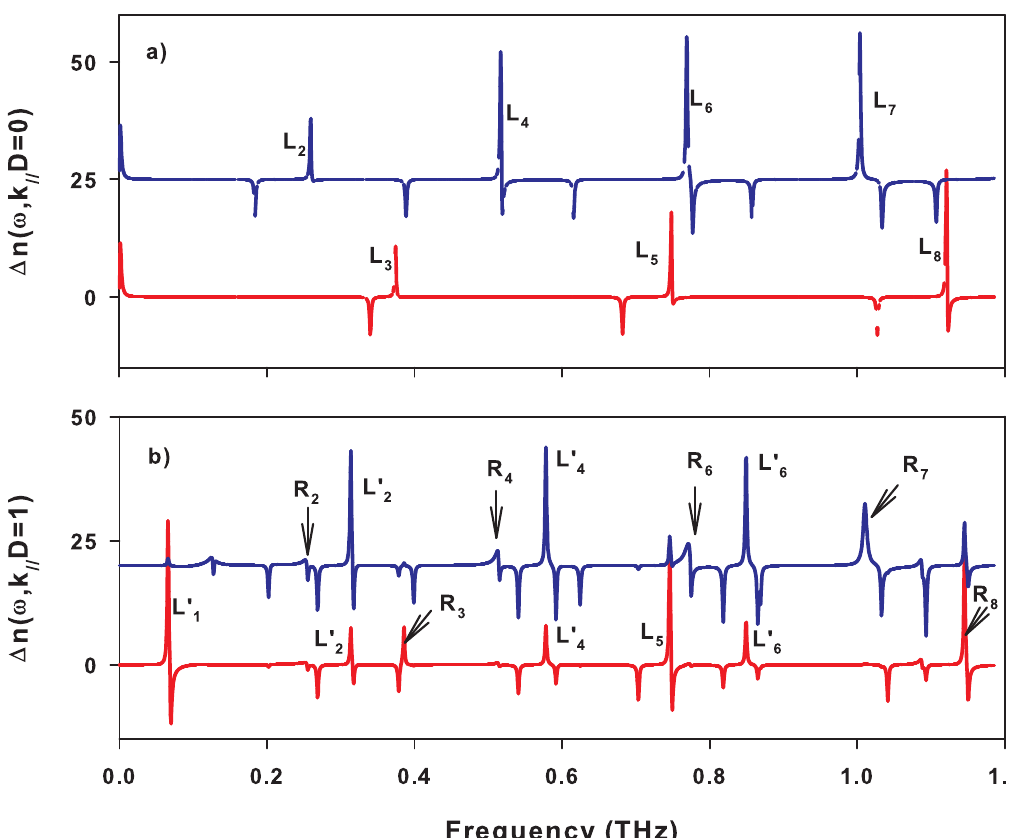
Figure 5. Same as in Figure 4, where the longitudinal (blue curves) and transverse (red curves) components are separated in the DOS, for k // D = 0 ( a ) and k // D = 1 ( b